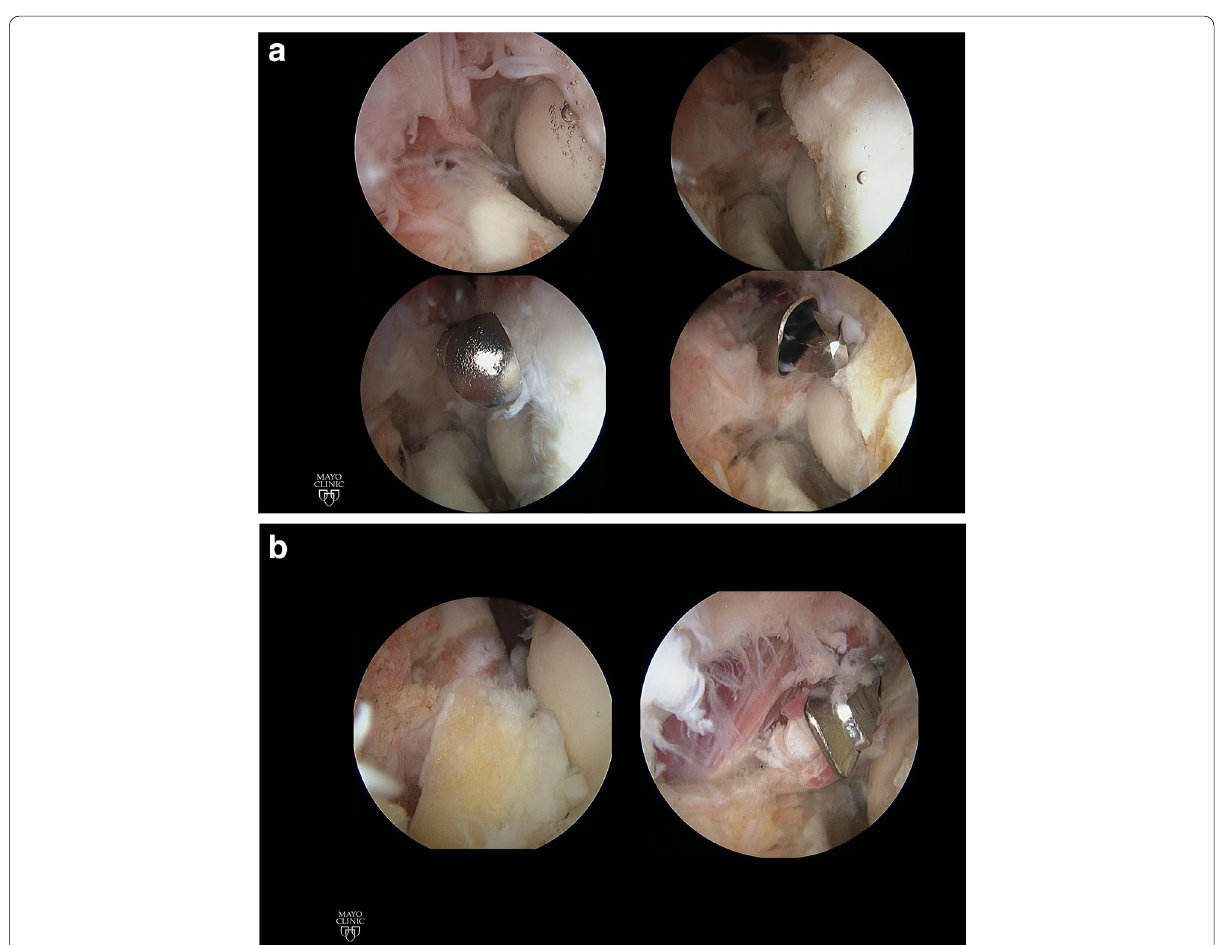
Fig. 4 Arthroscopic images show the various steps of elbow osteocapsular arthroplasty. A Establishing a view and bone work. B Bony work finalized, anterior